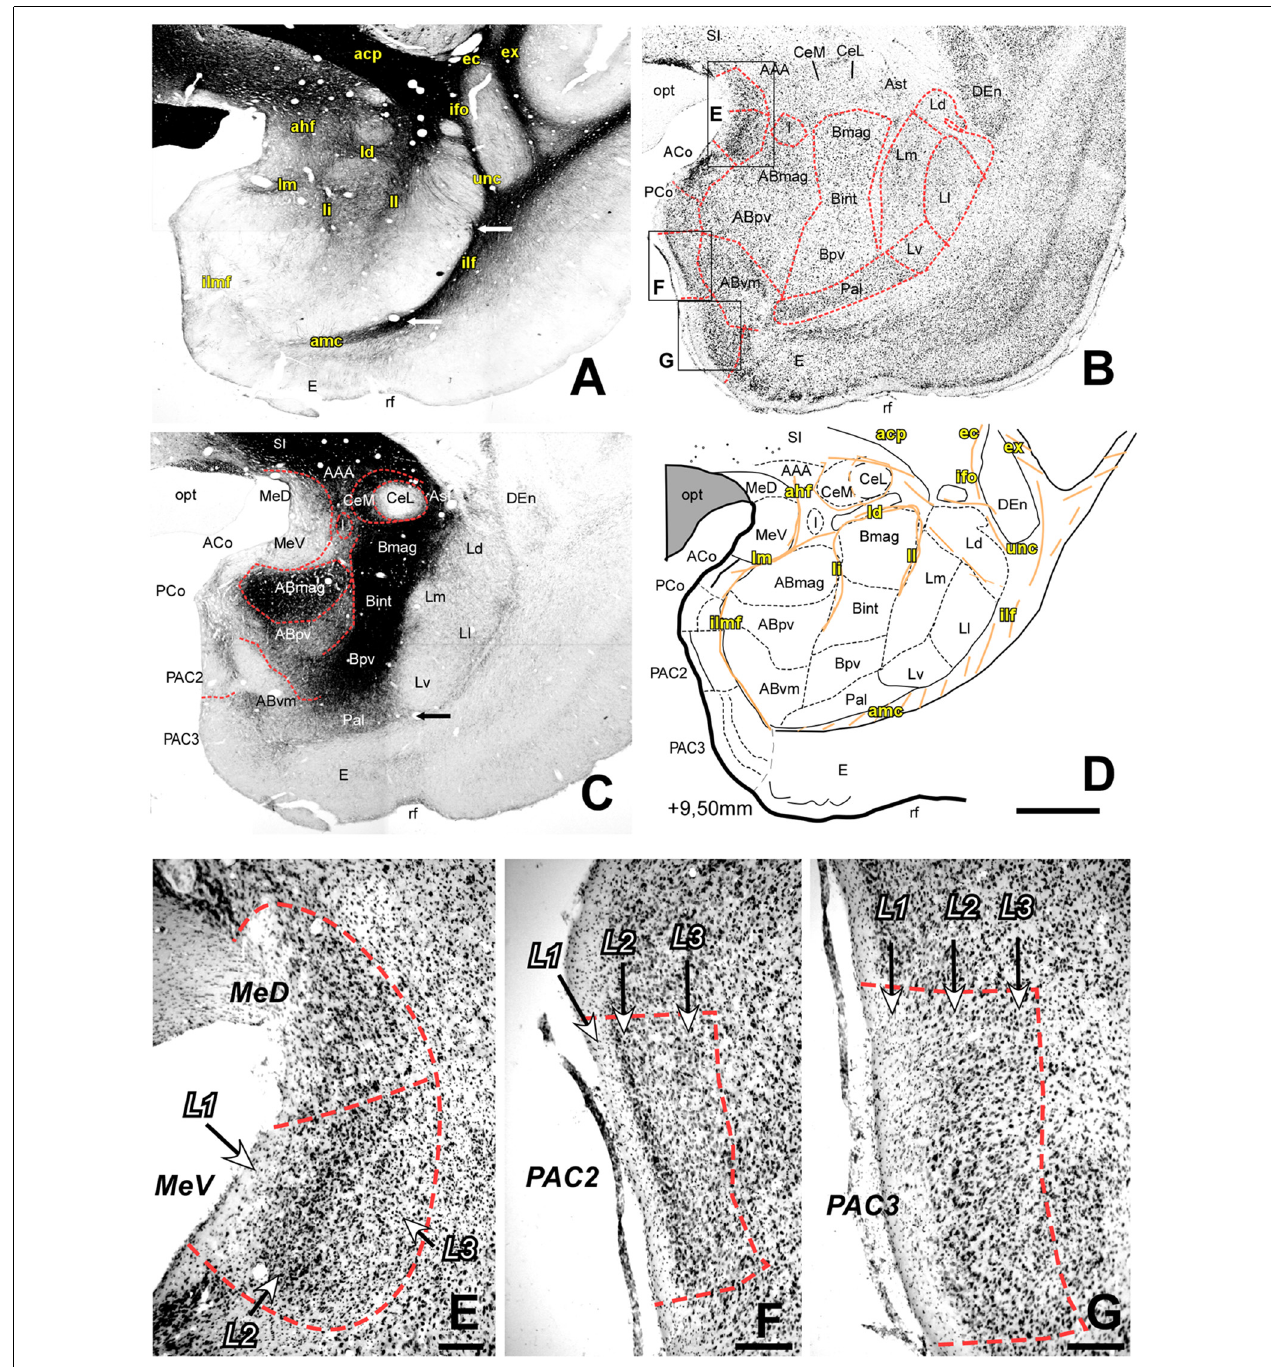
FIGURE 2 | Myelo- and cytoarchitecture, level 2 (Interaural 9.50 mm). Series of adjacent coronal sections stained for Gallyas (A) , Nissl (B) and AChE (C) and the corresponding drawing showing in black the territories of the AC and in orange the myelinic bundles schematically (D) . Unambiguous nuclear boundaries are drawn with a red dashed line. The divisions of the Ce showed huge differences in AChE staining intensity at this level (C) . In (A) , white arrows indicate the boundaries between the L and the Pal (bottom) and between the Ld and Ll subdivisions (top). Also, interesting is the presence of highly AChE stained I between the Ce and AB (C,D) . Myelin fibers help in the delimitation of the Ce and are abundant in the Bmag and Bint (A) . Panels (E–G) are high magnification bright-field photomicrographs of Nissl-stained sections in different portions of the superficial areas of the AC [corresponding to black squares in (B) ]; the layers are indicated in each region. In (E) , the rostral level of the Me shows three obvious layers in the ventral division which were not visible in the dorsal division. At this level, there are two subdivisions of the PAC, each of them showing a characteristic layer pattern: (F) In the PAC2 subdivision, L2 is thin and has densely packed cells; (G) PAC 3 has a large L2 formed by big and highly stained cells. Scale: 1 mm in (A–D) and 200 µ m in (E–G) .